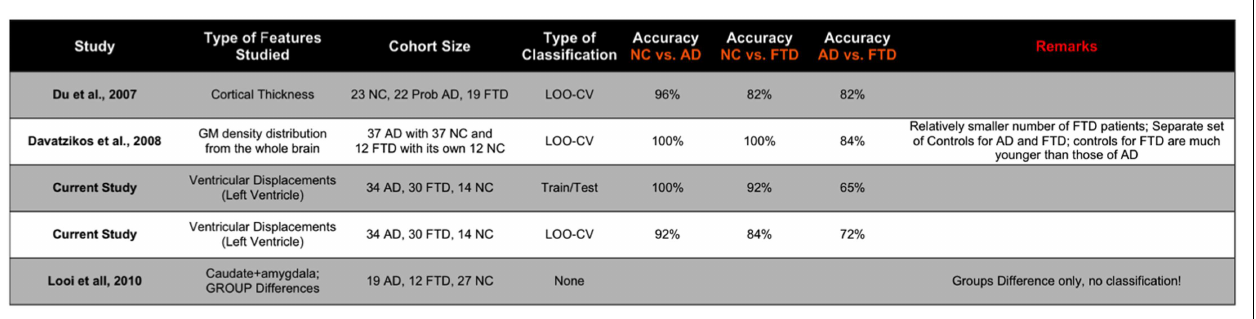
FIGURE 10 |Visualization of significant differences betweenAD and FTD using surface displacement features via SurfStat for the lateral ventricles – (A) the visualization above is for LV (B) and the one below